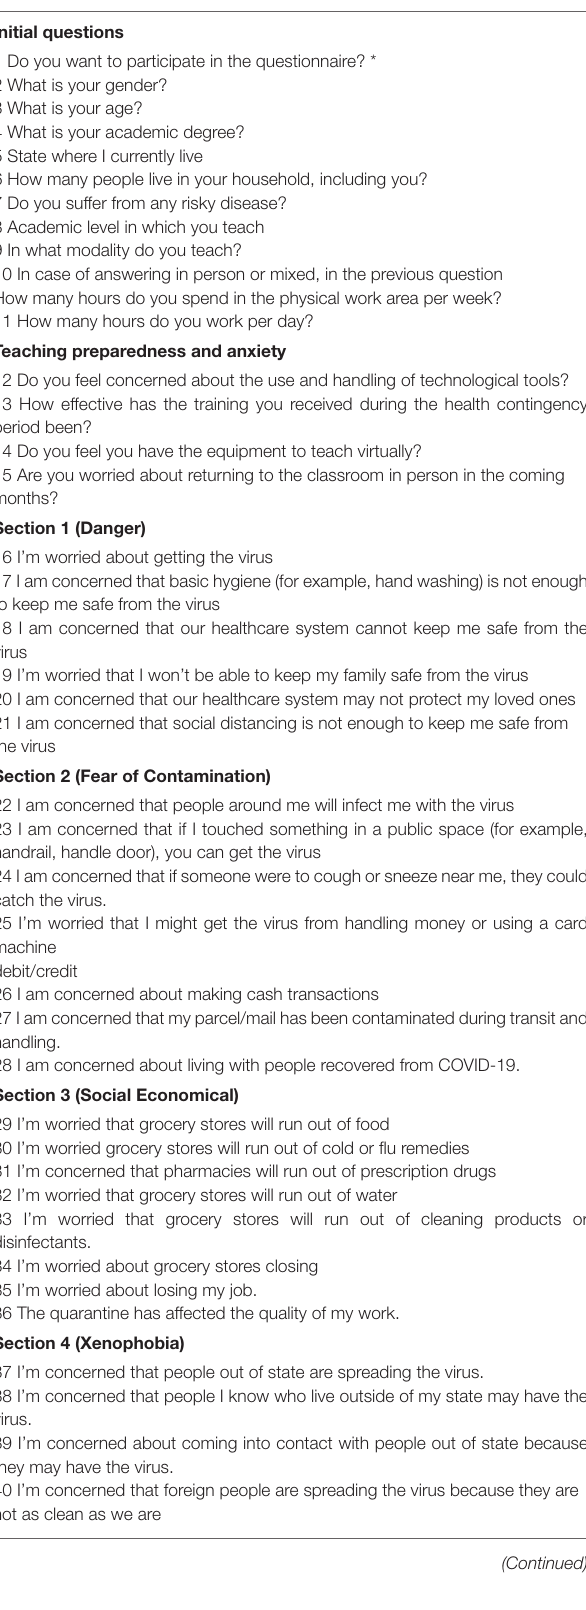
TABLE 1 | Adapted COVID STRESS SCALES for Academic professionals in